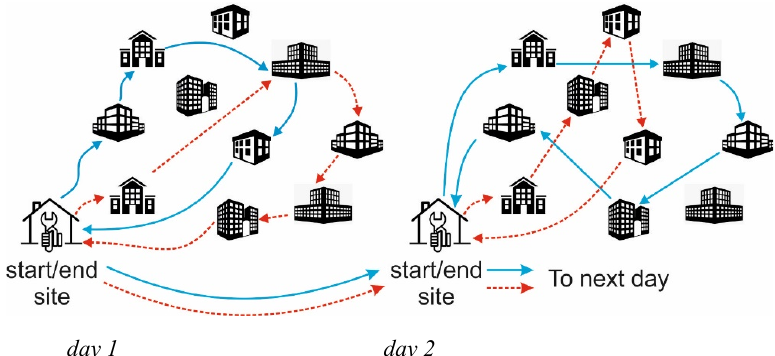
Fig. 1 . Suggested maintenance routes of two maintenance teams over two